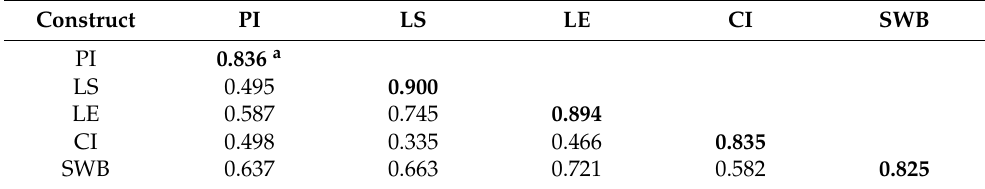
Table 4. The discriminant validity of the constructs, according to the Fornell–Larcker criterion.